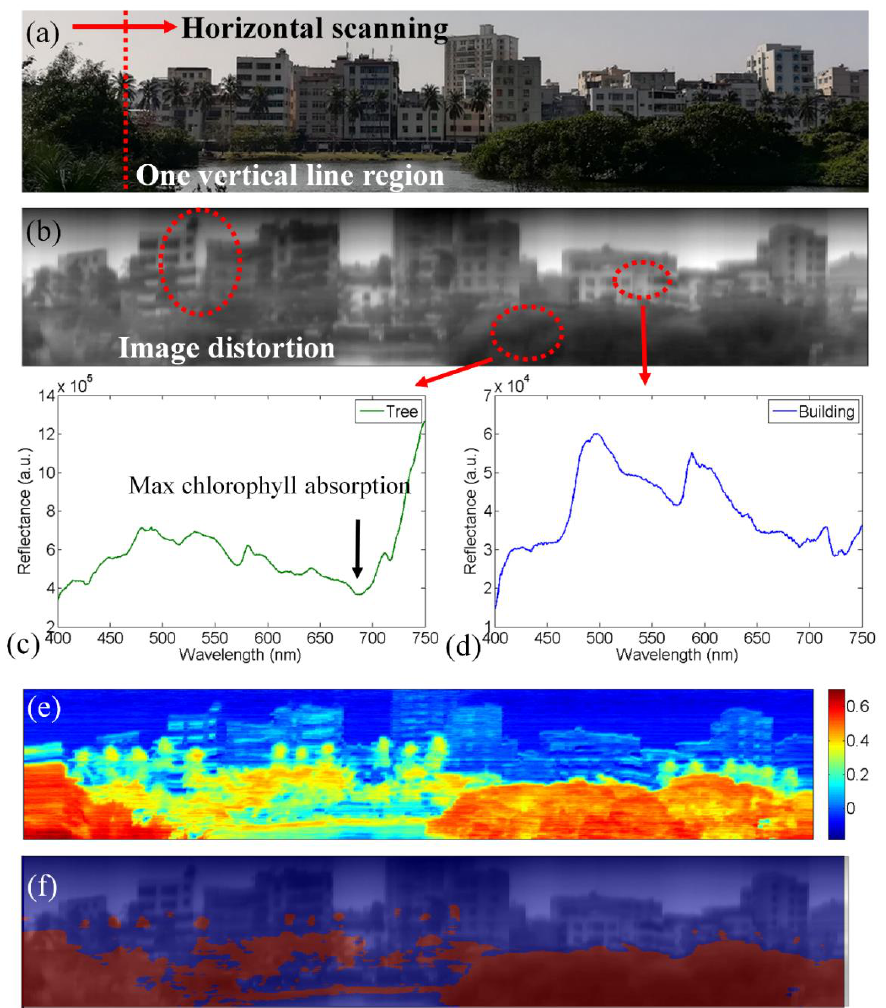
Figure 2. The selfie stick-based imaging spectrometer was utilized to scan environmental objects on campus. ( a ) Photo of the scanned object. The scanning was performed in the horizontal direction; ( b ) the spatial image obtained from the scanning result; ( c ) the reflectance spectrum from the tree region; ( d ) the reflectance spectrum from the building region; ( e ) the reflected light ratio index (RLRI) image based on the hyperspectral data cube; ( f ) the overlap of the spatial image and the binary image based on RLRI value.